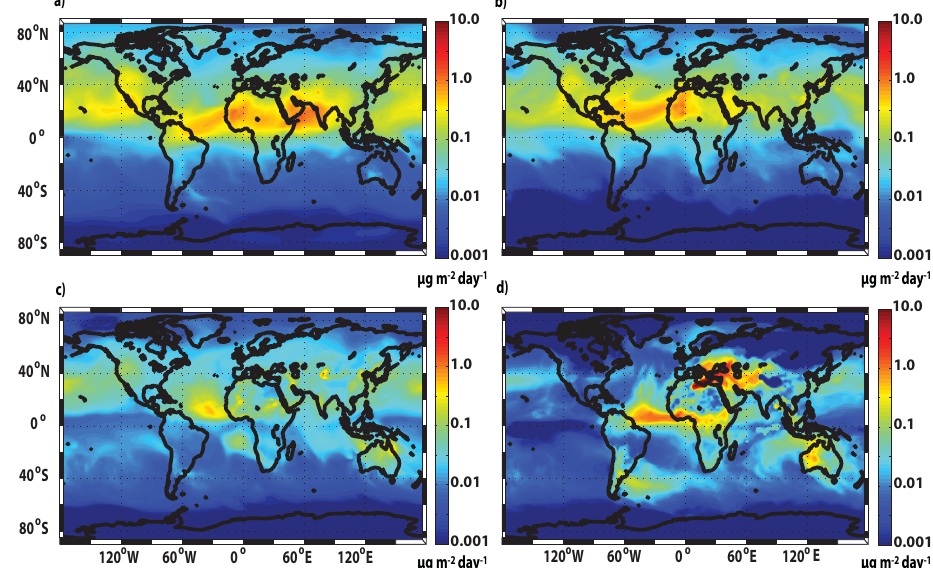
Fig. 5. Model-predicted seasonally averaged Fe(II) deposition rates (µgm − 2 day − 1 ) for (a) March–May (MAM), (b) June–August (JJA), (c) September–November (SON), and (d) December–February